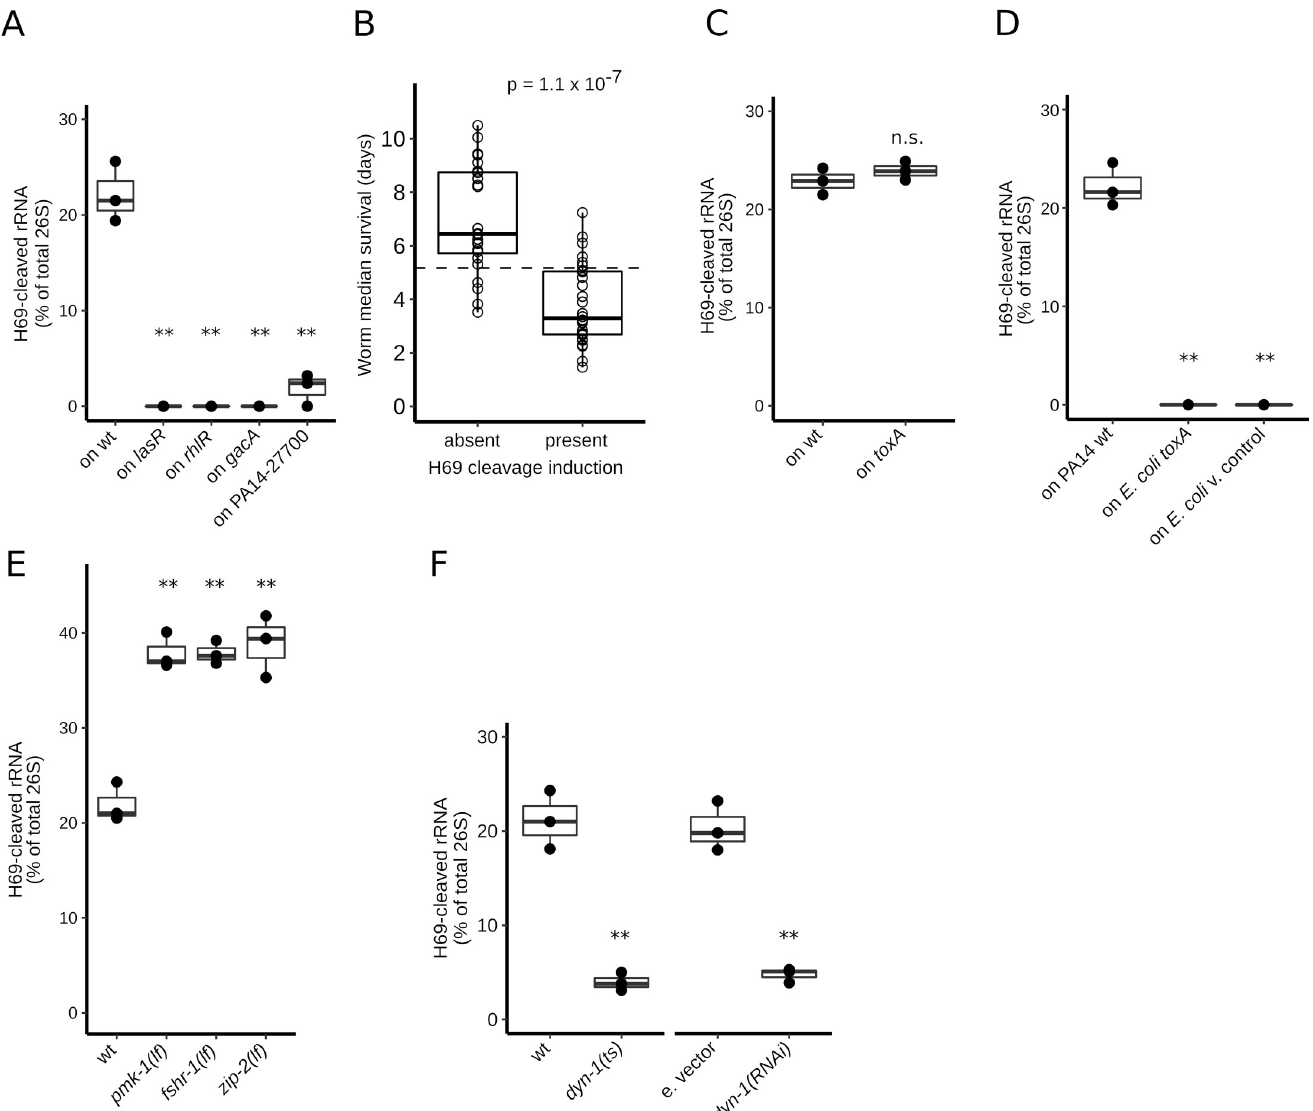
Fig 2. Relationship between H69 cleavage and virulence, virulence genes, and host genes. (A) H69 cleavage levels for Caenorhabditis elegans worms exposed 24 h to 4 PA14 mutants ( lasR , rhlR , gacA , and PA14_27700). All mutants are required for virulence towards C . elegans and 3 of them regulate bacterial QS ( lasR , rhlR , and gacA ). (B) Relationship between the capability to induce H69 cleavage and Pseudomonas aeruginosa virulence. The virulence of P . aeruginosa wild isolates is represented by the median survival time (in days) of wt worms exposed to the isolate, as determined previously [27]. H69 cleavage–inducing capacity (present or absent) was determined by analysis of total RNA from worms exposed to each isolate for 24 h, using capillary electrophoresis. The mean virulence of the 2 isolate sets is significantly different (Welch t test, p -value = 1.1 × 10 − 7 ). S3 Table contains source data for panel B. (C) H69 cleavage levels for worms exposed to a bacterial mutant of exotoxin A ( toxA ) or wt PA14 for 24 h. The cleavage levels are n.s. (Welch t test, p -value > 0.05). (D) H69 cleavage levels for worms exposed to E . coli expressing the toxA gene or v. control for 24 h. H69 cleavage for PA14-exposed worms is included as control. (E) H69 cleavage levels of C . elegans lf mutants in 3 host response pathways ( pmk-1 , fshr-1 , and zip-2 ). The worms were exposed to PA14 for 24 h. (F) H69 cleavage levels, following exposure to PA14 for 24 h, for C . elegans worms with reduced dynamin ( dyn-1 ) gene function. Two experimental conditions are shown: (1) a dyn-1 ts (restrictive at 25˚ C) is compared to wt worms; and (2) dyn-1 RNAi knockdown in the intestine (using strain VP303) is compared with e. vector RNAi condition. For all graphs, “ � ” indicates p -value < 0.05, and “ �� ” represents p -value < 0.01 for Welch t test comparisons between the plotted conditions. S1 Data contains source data for panels A and C–F. e. vector, empty vector; H69, helix 69; lf , loss of function; n.s., not significantly different; QS, quorum sensing; RNAi, RNA-mediated interference; ts , temperature sensitive; v. control, vector control; wt,